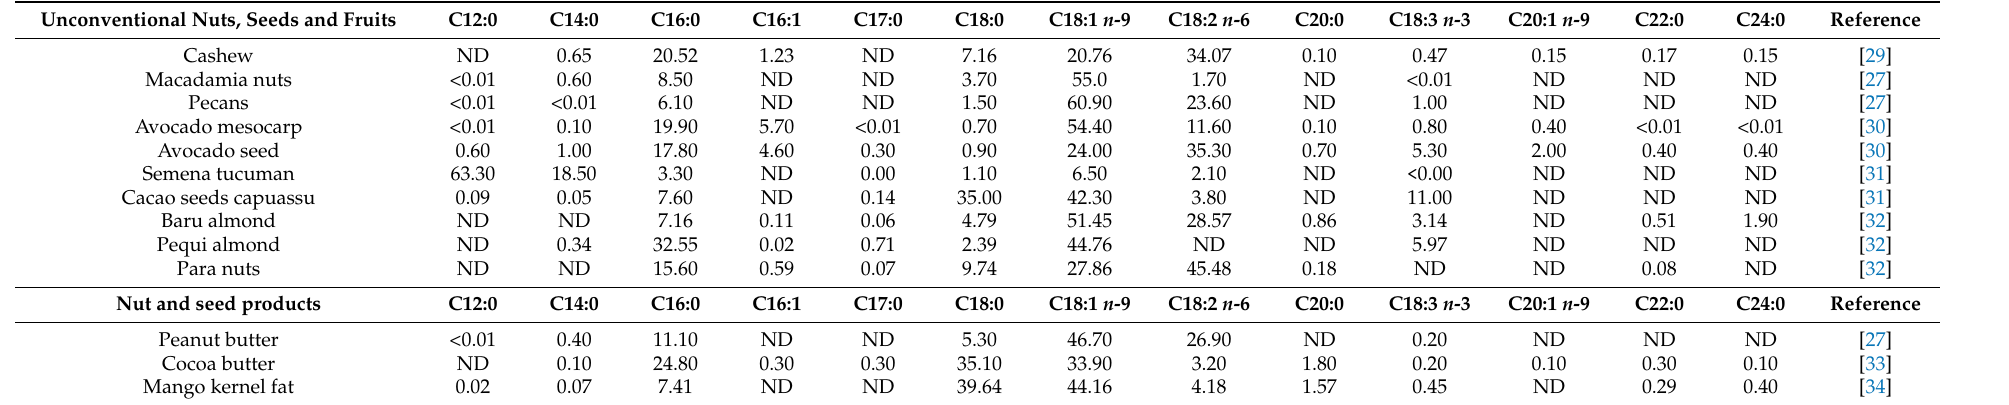
Data are presented as mean. Uncertainty of measurement is available in the reference sources. ND: not